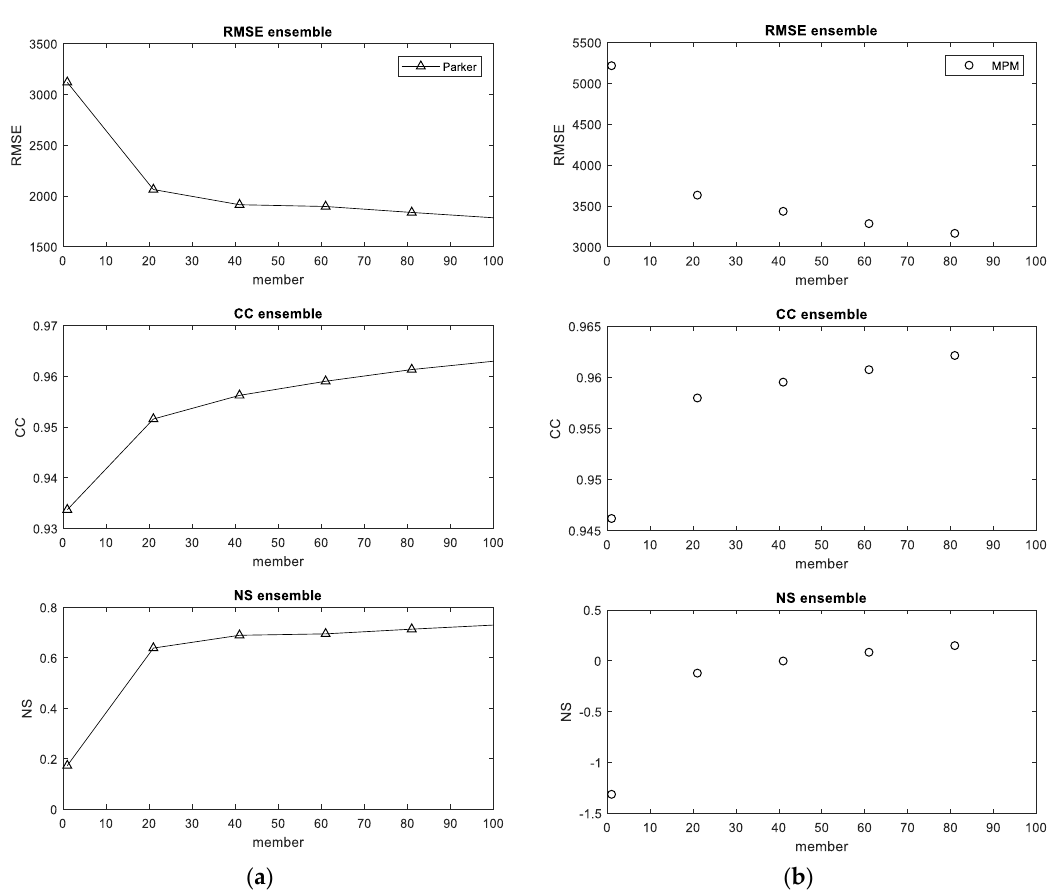
Figure 6. Comparison of prediction and observation obtained from different ensemble sizes in Dahan River, ( a ) Parker; ( b ) MPM. Comparison observations and hindcasting